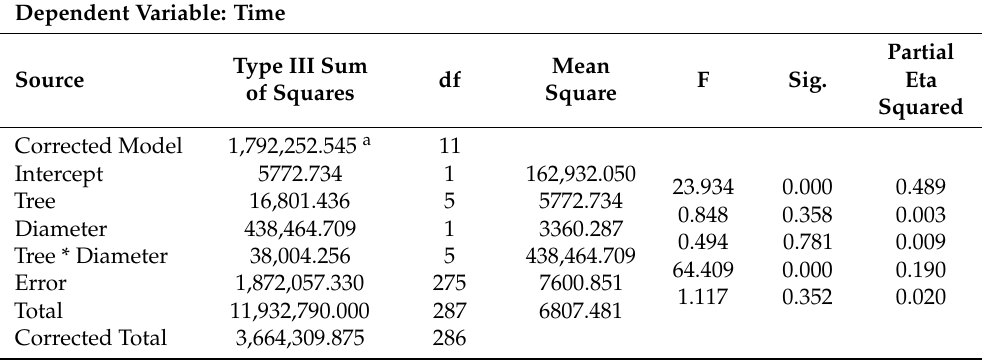
Table 10. Estimates and tests of effect size (tree, diameter, tree/diameter).